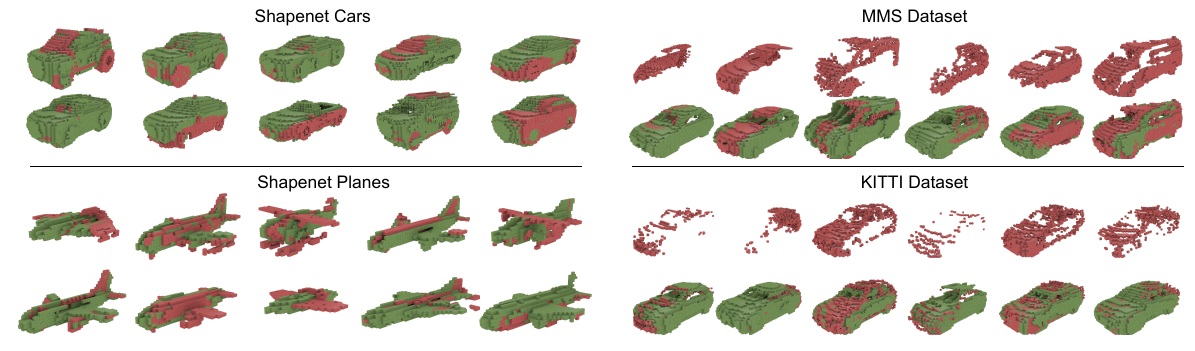
Figure 6. Examples for synthetic data (a) and real data (b)